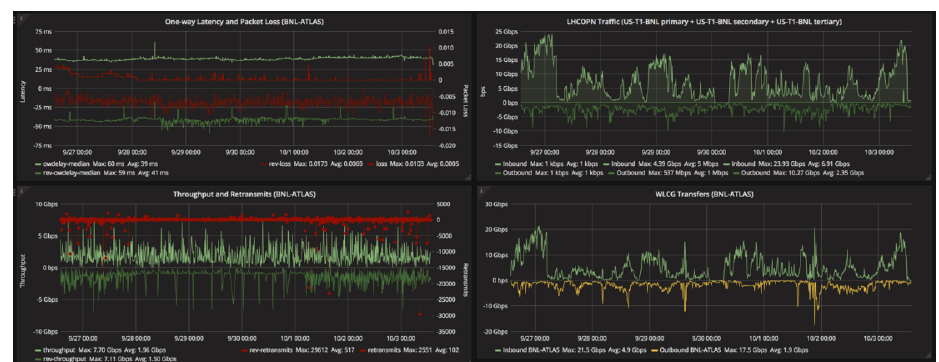
Figure 3: OSG Network Monitoring Platform - distributed deployment that collects, stores, Figure 4: Grafana based dashboard showing for a given site a combined view of in- bound / outbound latency and throughput as measured by perfSONAR side-by-side with the network utilisation as registered by LHCOPN routers and throughput computed from FTS data